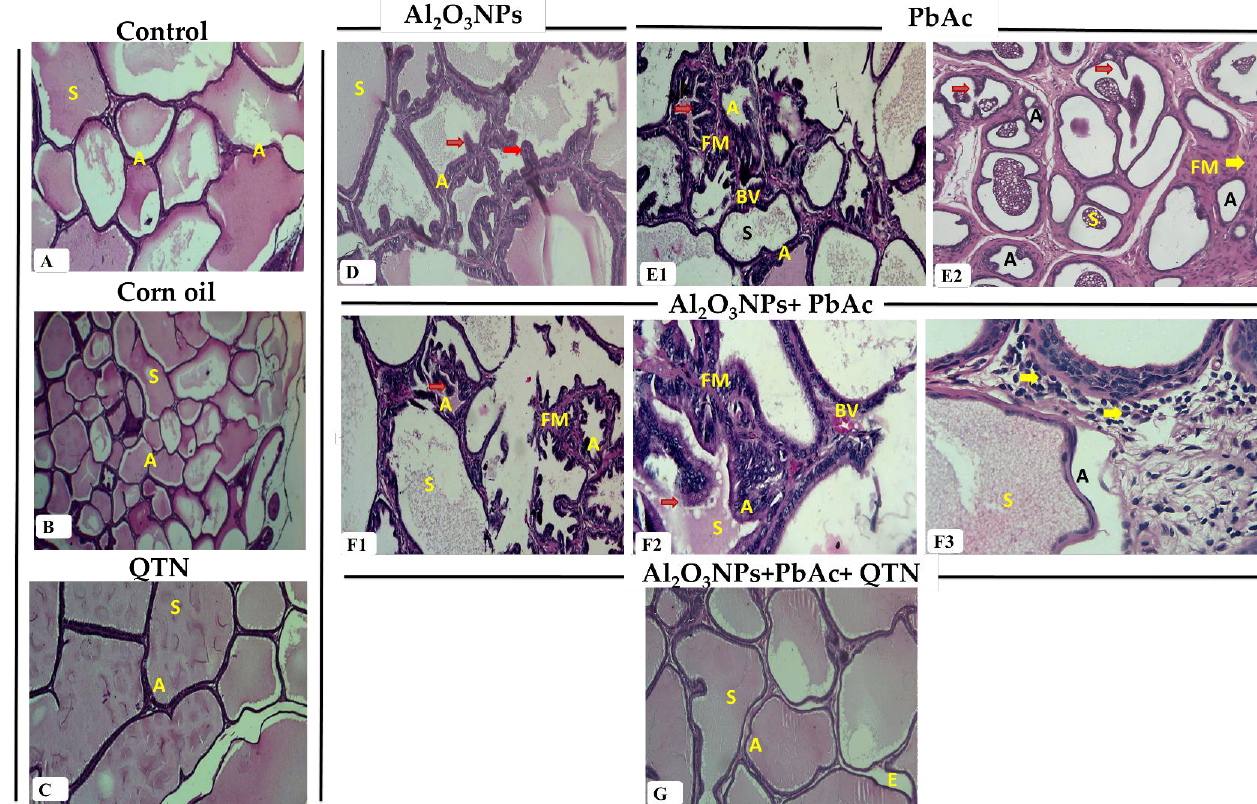
Figure 3. ( A ) Prostate gland of the control group showing normal structure as different sizes and shapes acini (A) with prostatic secretion (S) in the lumen (H&E, X100). ( B ) Prostate gland of corn oil-treated group showing normal structure with normal acini (A) and secretion (S) in the lumen (H&E, ×40). ( C ) Prostate gland of QTN-treated group showing normal acini (A) and secretion (S) in the lumen (H&E, ×100). ( D ) Prostate gland of Al 2 O 3 NPs-exposed group showing hyperplasia of acini (A) with papillary folds ( red arrow ) and scanty secretion (S) in the lumen (H&E, ×100). ( E1 ) Prostate gland of PbAc-exposed group showing prostatic acinar hyperplasia with papillary folds ( red ar- row ), destructed acini and decreasing acinar size (A), interstitial inflammatory cells ( Yellow arrow ) and congested blood vessels (BV), thick fibro-muscular stroma (FM) as well as little secretion (S) (H&E, ×100). ( E2 ) Prostate gland of PbAc-exposed group showing prostatic acinar hyperplasia with papillary folds (red arrow), destructed acini and decreasing acinar size (A), interstitial inflammatory cells (Yellow arrow) and thick fibro-muscular stroma (FM) as well as little secretion (S) (H&E, X100). ( F1 ) Prostate gland of Al 2 O 3 NPs and PbAc co-exposed group showing marked prostatic acinar hy- perplasia with papillary folds ( red arrow ), decreasing acinar size, destructed acini (A), thick fibro- muscular stroma (FM), and little secretion (S)(H&E, ×100). ( F2 ) Prostate gland of Al 2 O 3 NPs and PbAc co-exposed group showing acini lined with vacuolated epithelium, acinar hyperplasia with papil- lary folds ( red arrow ), destructed acini, thick fibro-muscular stroma (FM), few secretions (S), inflam- matory cells ( Yellow arrow ) around the acini and congested blood vessels (BV) (H&E, ×400). ( F3 ) Prostate gland of Al 2 O 3 NPs and PbAc co-exposed group showing prostatic acinar ( arrow ) with se- cretion (S) and inflammatory cells ( Yellow arrow ) around the acini (H&E, ×400). G: Prostate gland of Al 2 O 3 NPs and PbAc co-exposure and QTN-treated group showing normal structure with normal acini (A), secretion (S) in the lumen, and very mild edema (E) (H&E, ×100). The prostate gland of Al 2 O 3 NP s , PbAc, and co-exposure groups exhibited destruction of some acini and decreasing acinar size compared to the control group. Others had vac- uolated flattened epithelium with epithelial hyperplasia and marked papillary projec- tions. There were little vacuolated secretions in the lumen. Interstitial tissues showed con- gested blood vessels, edema, and monocellular inflammatory cells. The fibro-muscular layer was thicker than the control group (Figure 3D,E1,E2,F1 – F3). QTN could improve the